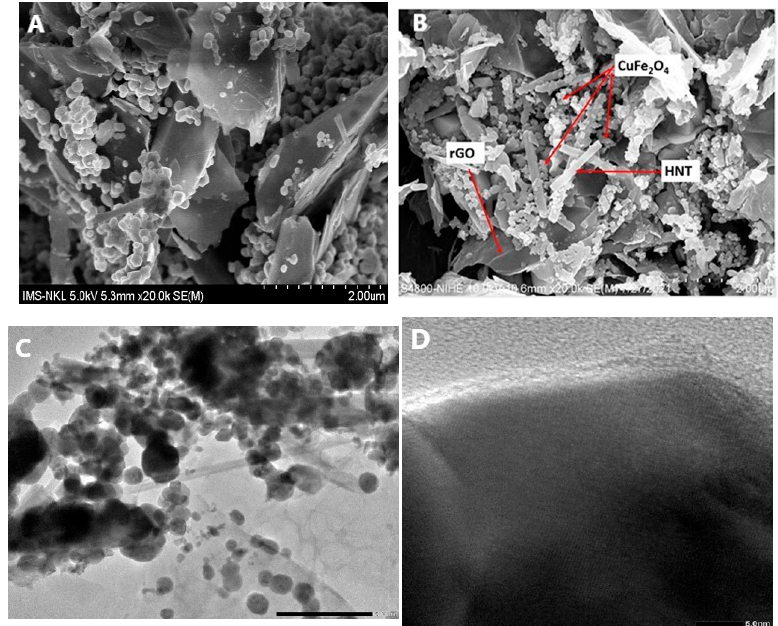
Figure 4. SEM ( A , B ) and HRTEM images ( C , D ) of CuFe 2 O 4 -70%/rGO/HNT.